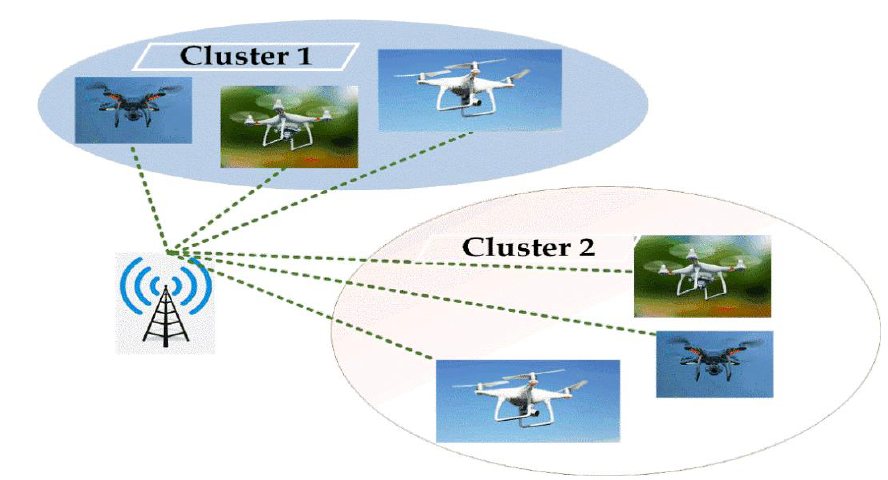
Figure 6. Clustering architecture in BOLD.